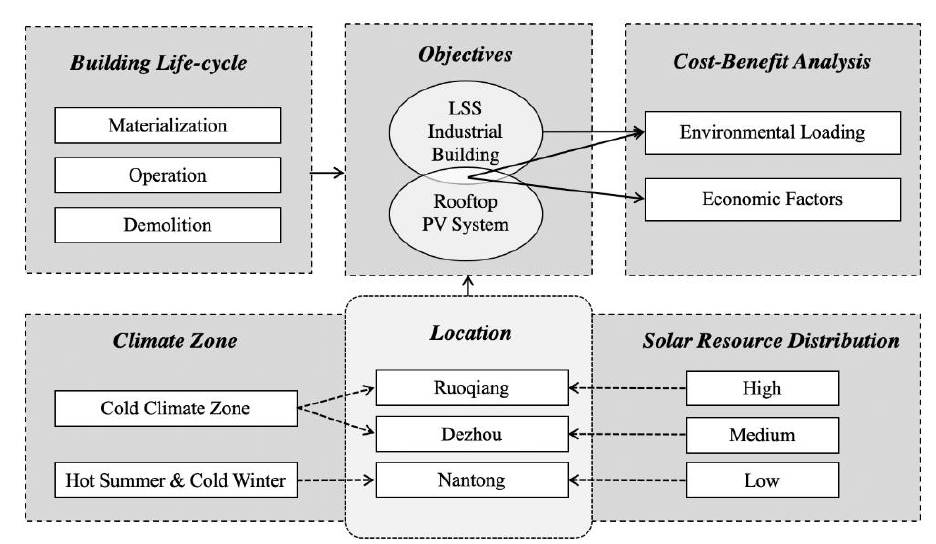
Figure 1 The research